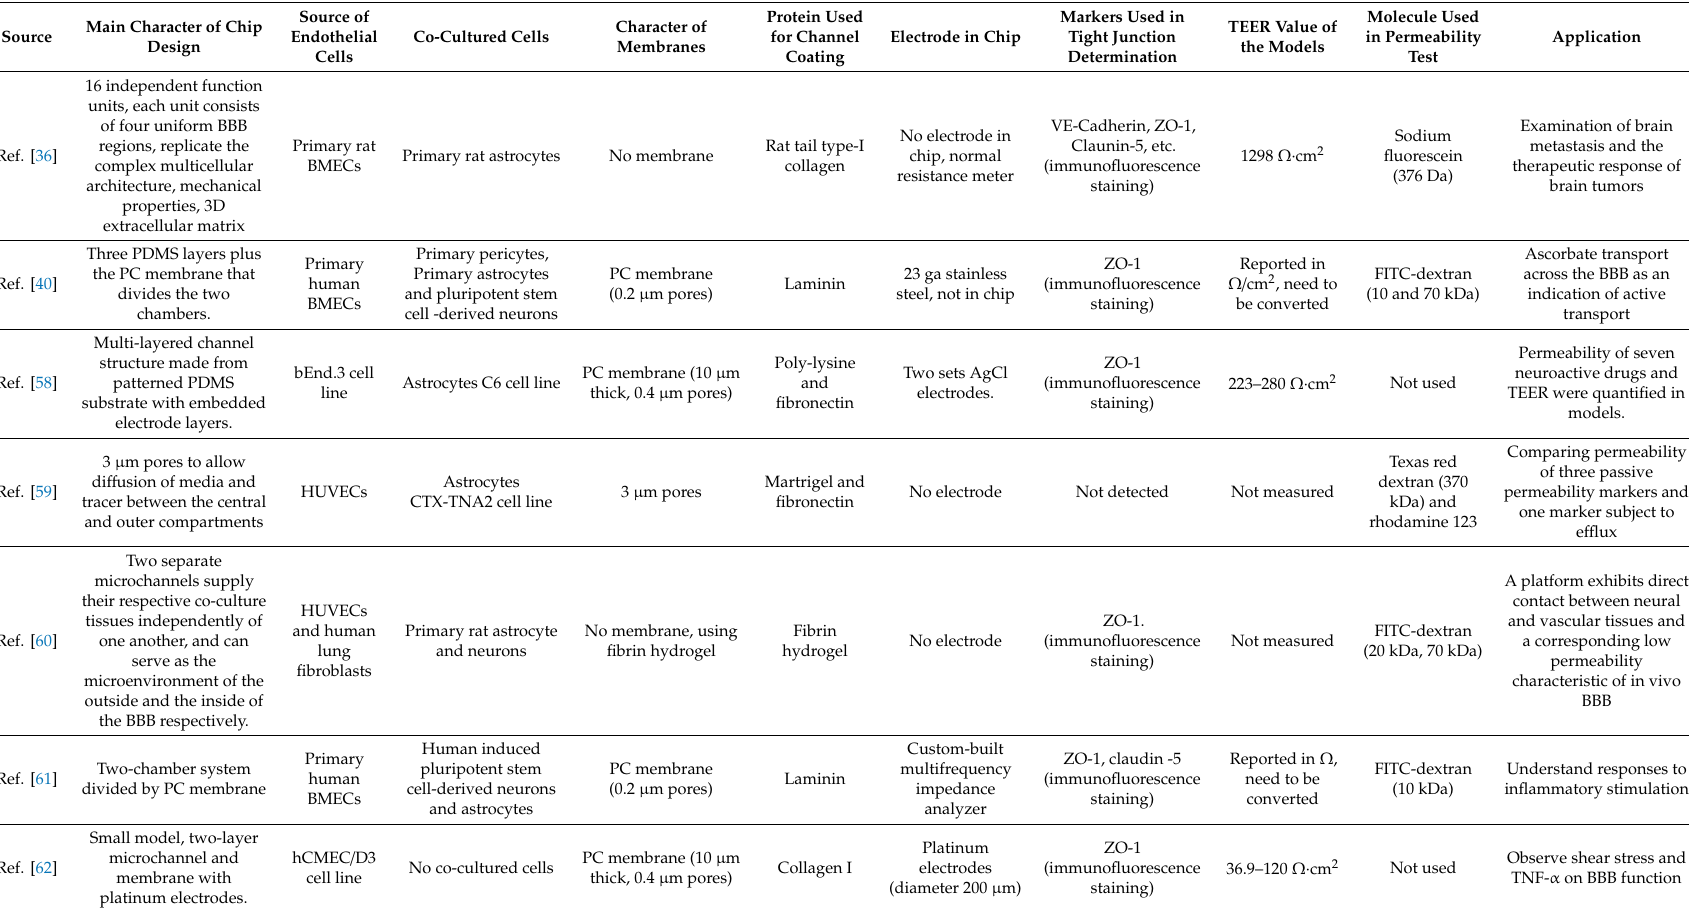
Table 1. The main characters of some microfluidic blood-brain barrier (BBB)